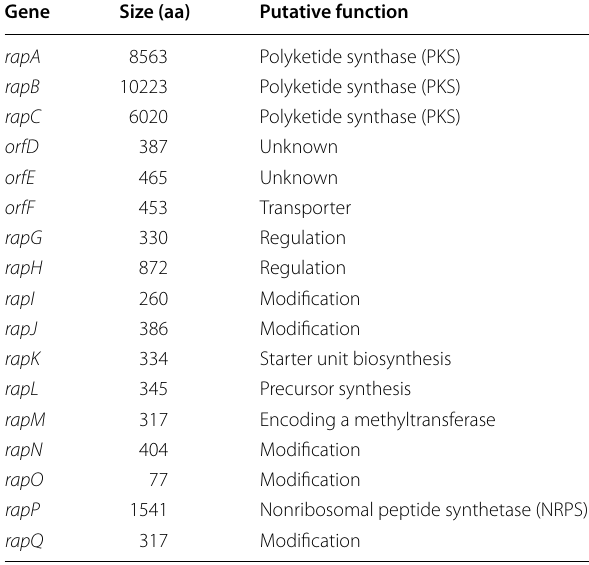
biosynthetic genes in